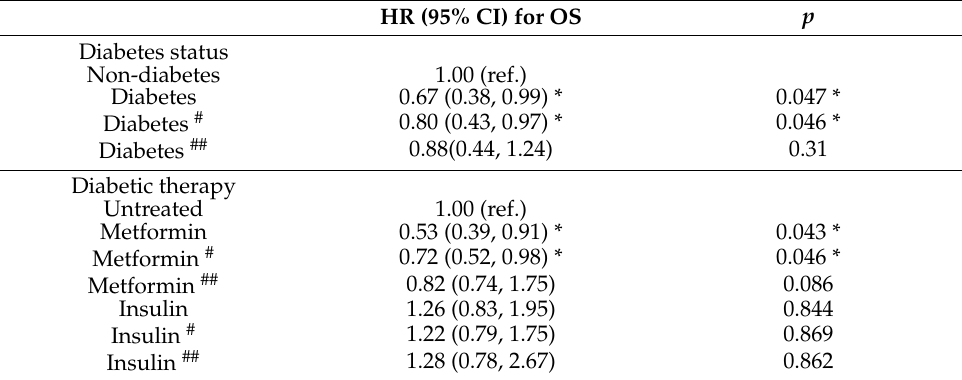
Figure 2. ( a ). OS survival curves of NSCLC in diabetes groups. ( b ). PFS survival curves of NSCLC in diabetes groups. * indicates significance p < 0.05. Table 3. Associations of OS with status of T2DM and with diabetic